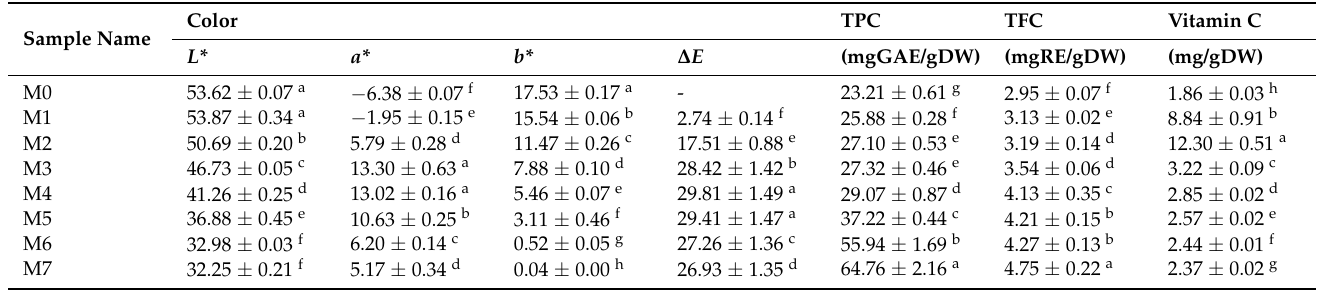
Table 2. Changes in color, total phenolic contents, total flavonoid contents and vitamin C of mulberry fruits during